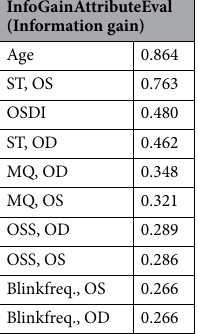
Table 4. Most important features predicting an unstable tear film in the right eye with information gain. OD right eye, OS left eye, ST Schirmer test, MQ meibum quality, OSDI ocular surface disease index, Blinkfreq blink frequency, OSS ocular surface staining.